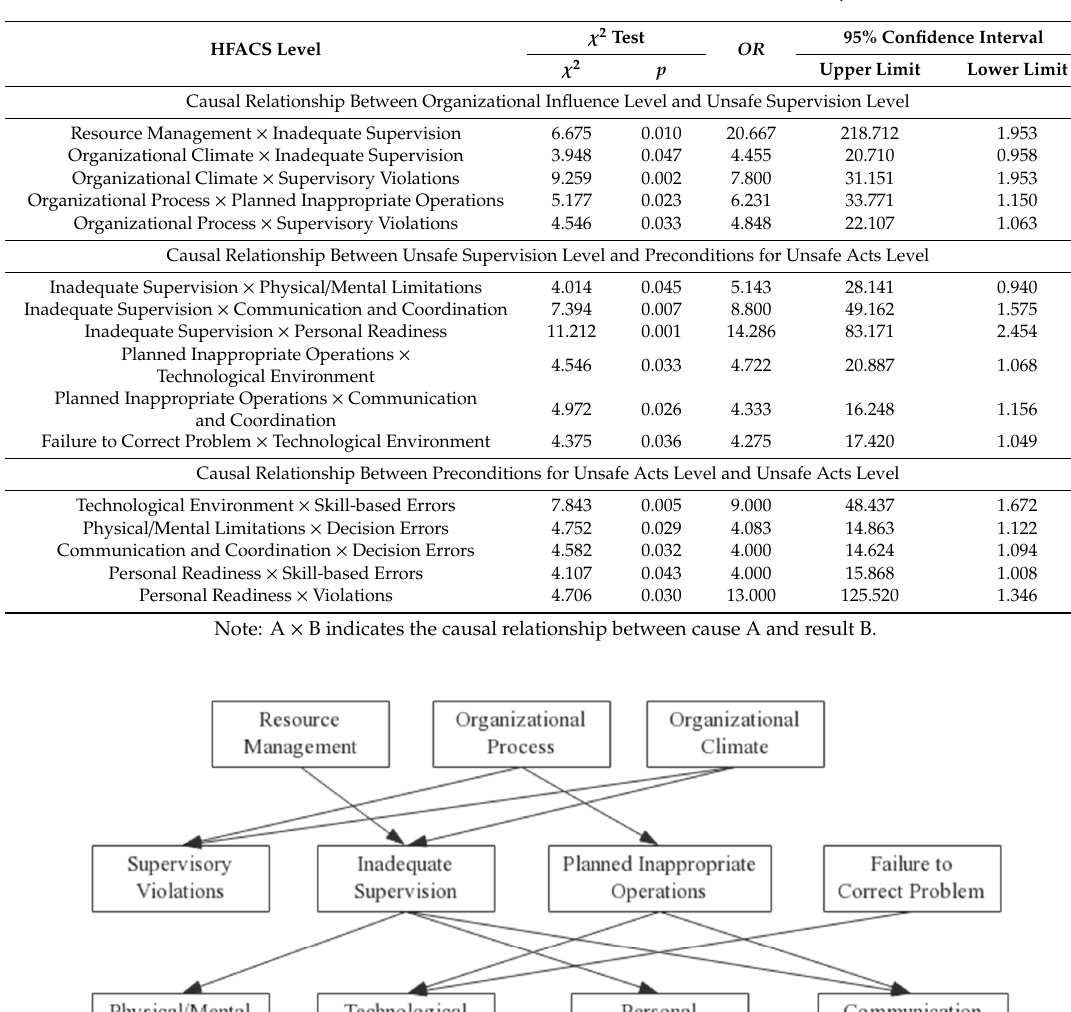
Table 6. χ 2 / OR value statistics between different levels of factors in HFACS ( p < 0.05, OR > 1).